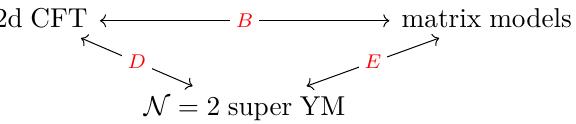
Figure 2 . Here the arrow D is nothing but the AGT correspondence while the arrow E represents the so-called matrix model version of the AGT duality